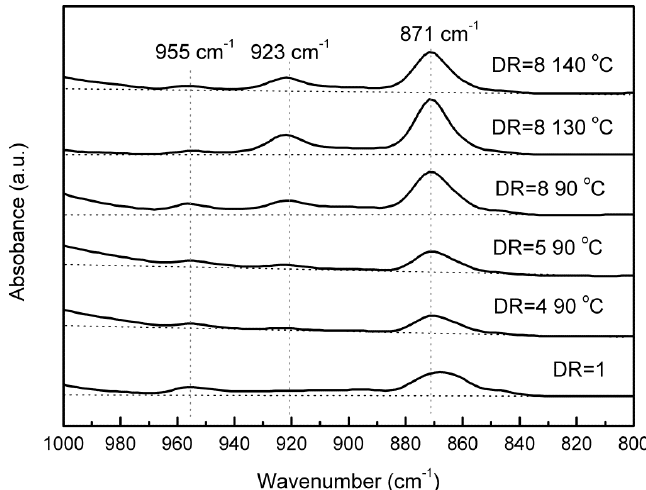
Figure 6. Infrared spectra in the 800–1000 cm − 1 region for a series of DR prepared at different drawing temperature. Note the appearance of the bands at 923 and 912 cm − 1 characteristic of α and β crystals, respectively.